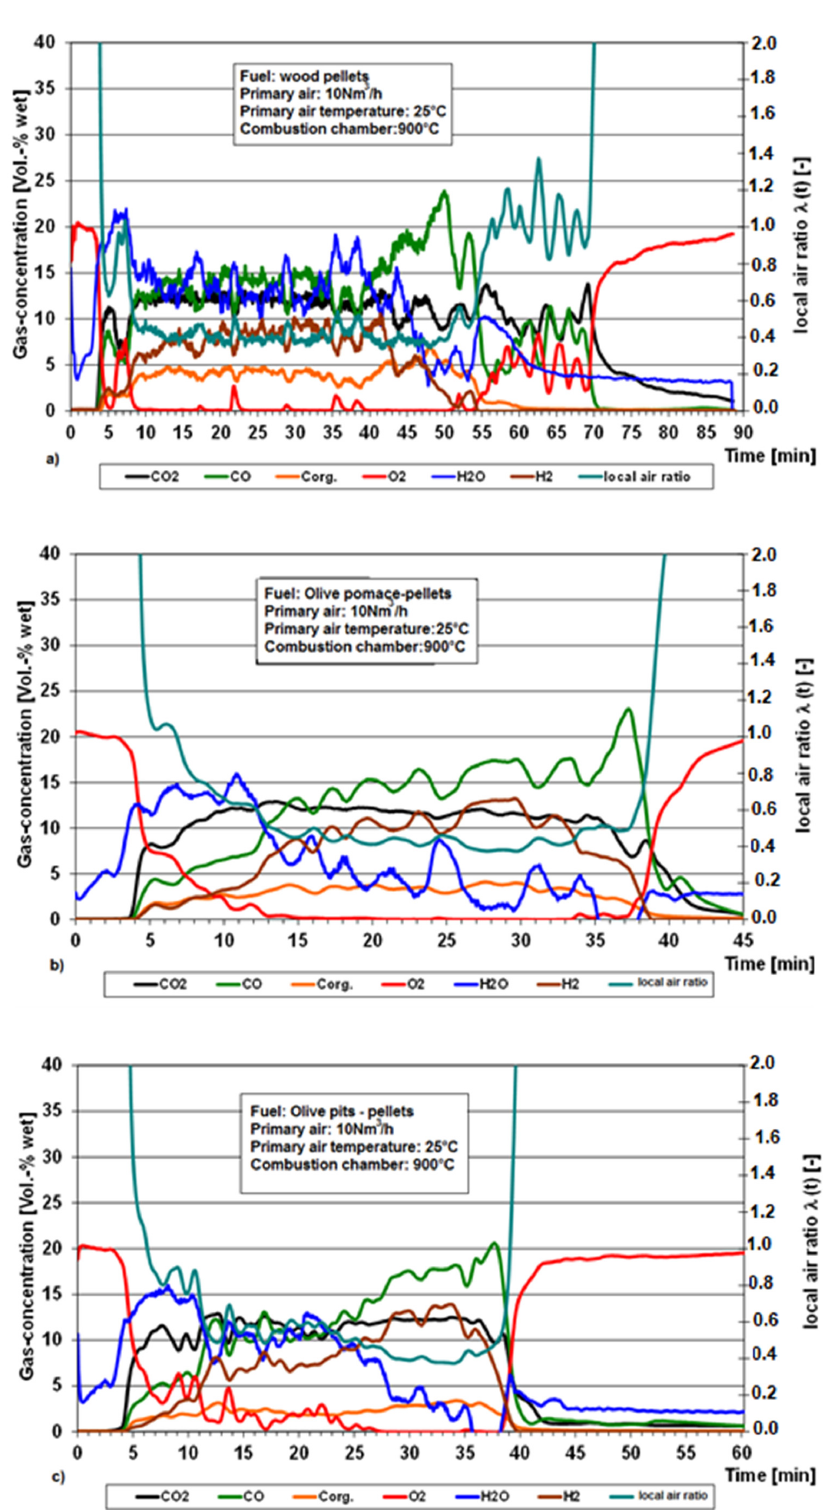
Figure 6. Concentrations of gaseous emissions analysis above the fixed bed (in the freeboard): ( a ) 100% standard wood pellets, ( b ) OP and ( c ) 100% OP i . Experimental conditions: Primary air 10 Nm 3 /h; primary air temperature 25 °C and combustion chamber temperature 900 °C.